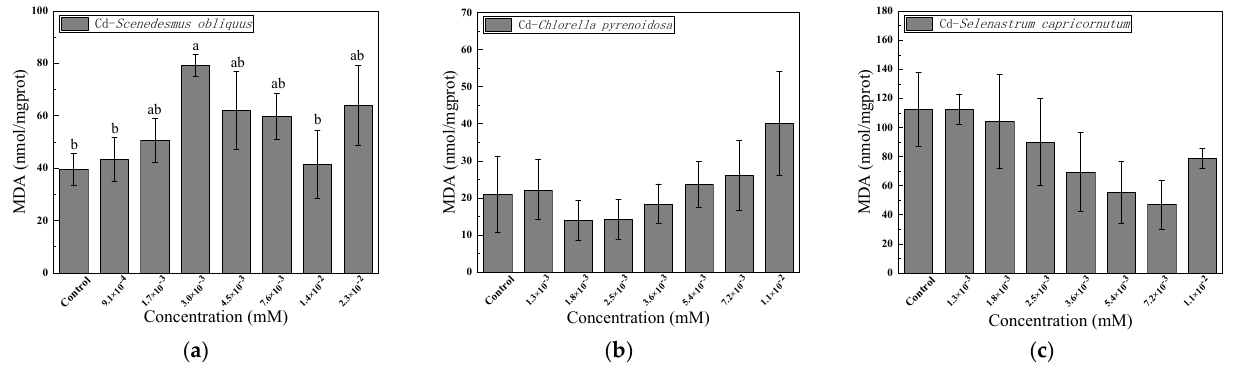
Figure 4. Effects of 96-h Cd exposure on the content of malondialdehyde (MDA) in S. obliquus ( a ), C. pyrenoidosa ( b ) and S. capricornutum ( c ). The different letters: a, and b in the figure indicated that significant differences ( p < 0.05).